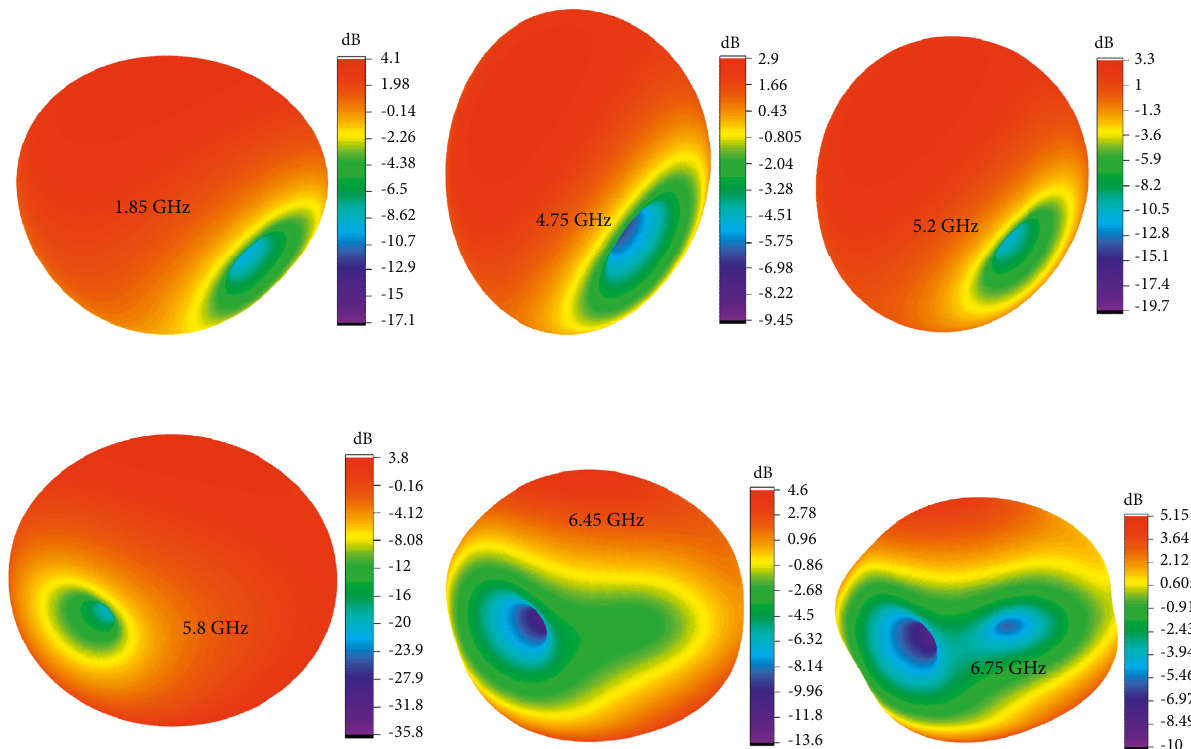
Figure 8: Gain of the proposed OBS antenna.